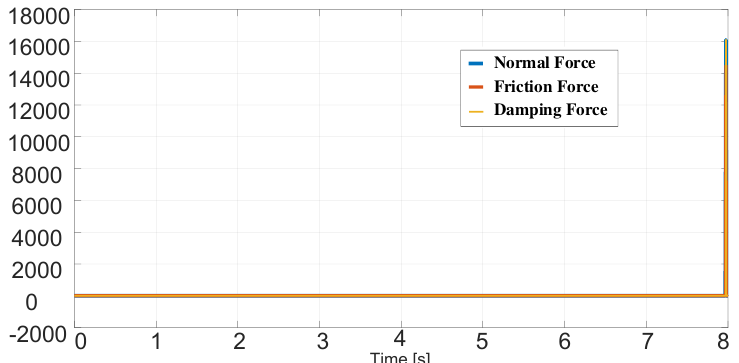
Figure 16. Contact forces between the second dumbbell and the target